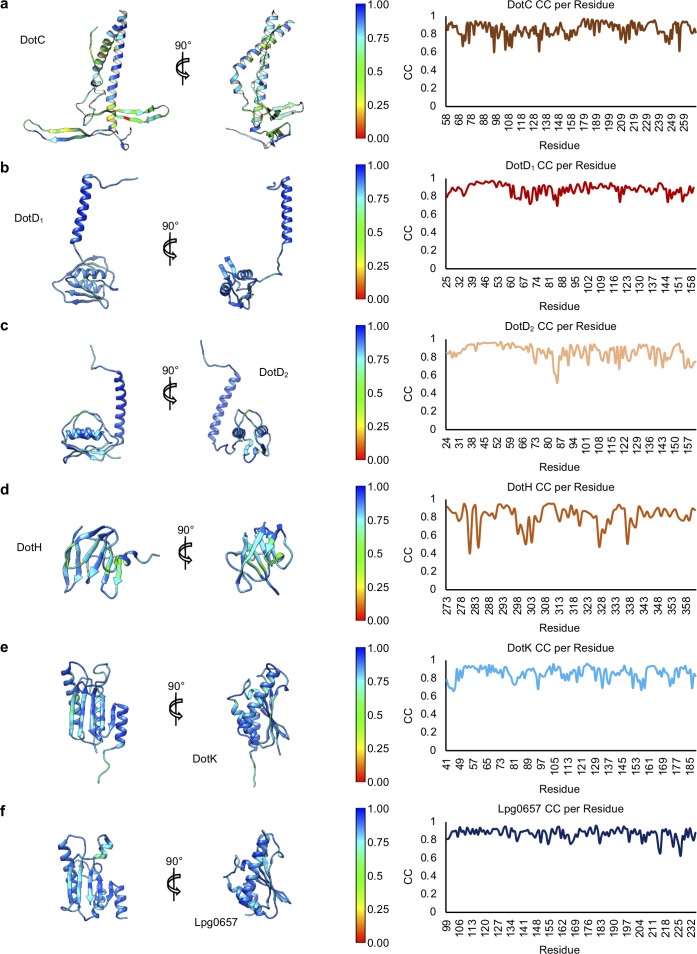
Model-map correlation for each protein within the Lp ΔDotG OMC.(a–f) The correlation coefficient for each protein within the Lp ΔDotG OMC is depicted as a heat map on the corresponding structure and is plotted against the residue number.